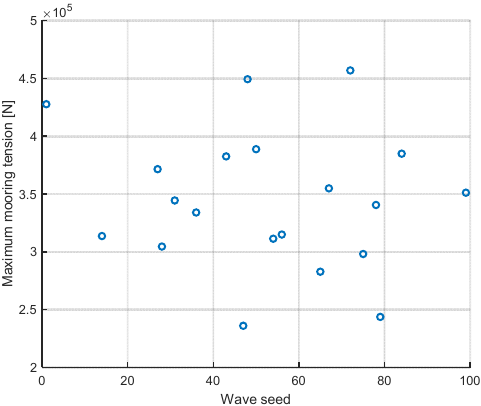
Figure 21. Maximum horizontal excursion for different seed numbers. The maximum values extracted from each simulation are fitted to the Gumbel distri- bution Equation (7), estimating the distribution parameters ( σ and µ ) with the L-moments method. Moreover, to evaluate the accuracy of fitted Gumbel distribution, two examples of the quantiles of the sample data versus the theoretical quantile values from a normal distribution are plotted in Figures 22 and 23. It can be observed that most points distribute along the reference line despite some discrepancy of tail points. This indicates that the estimated Gumbel distribution matches well with empirical data.